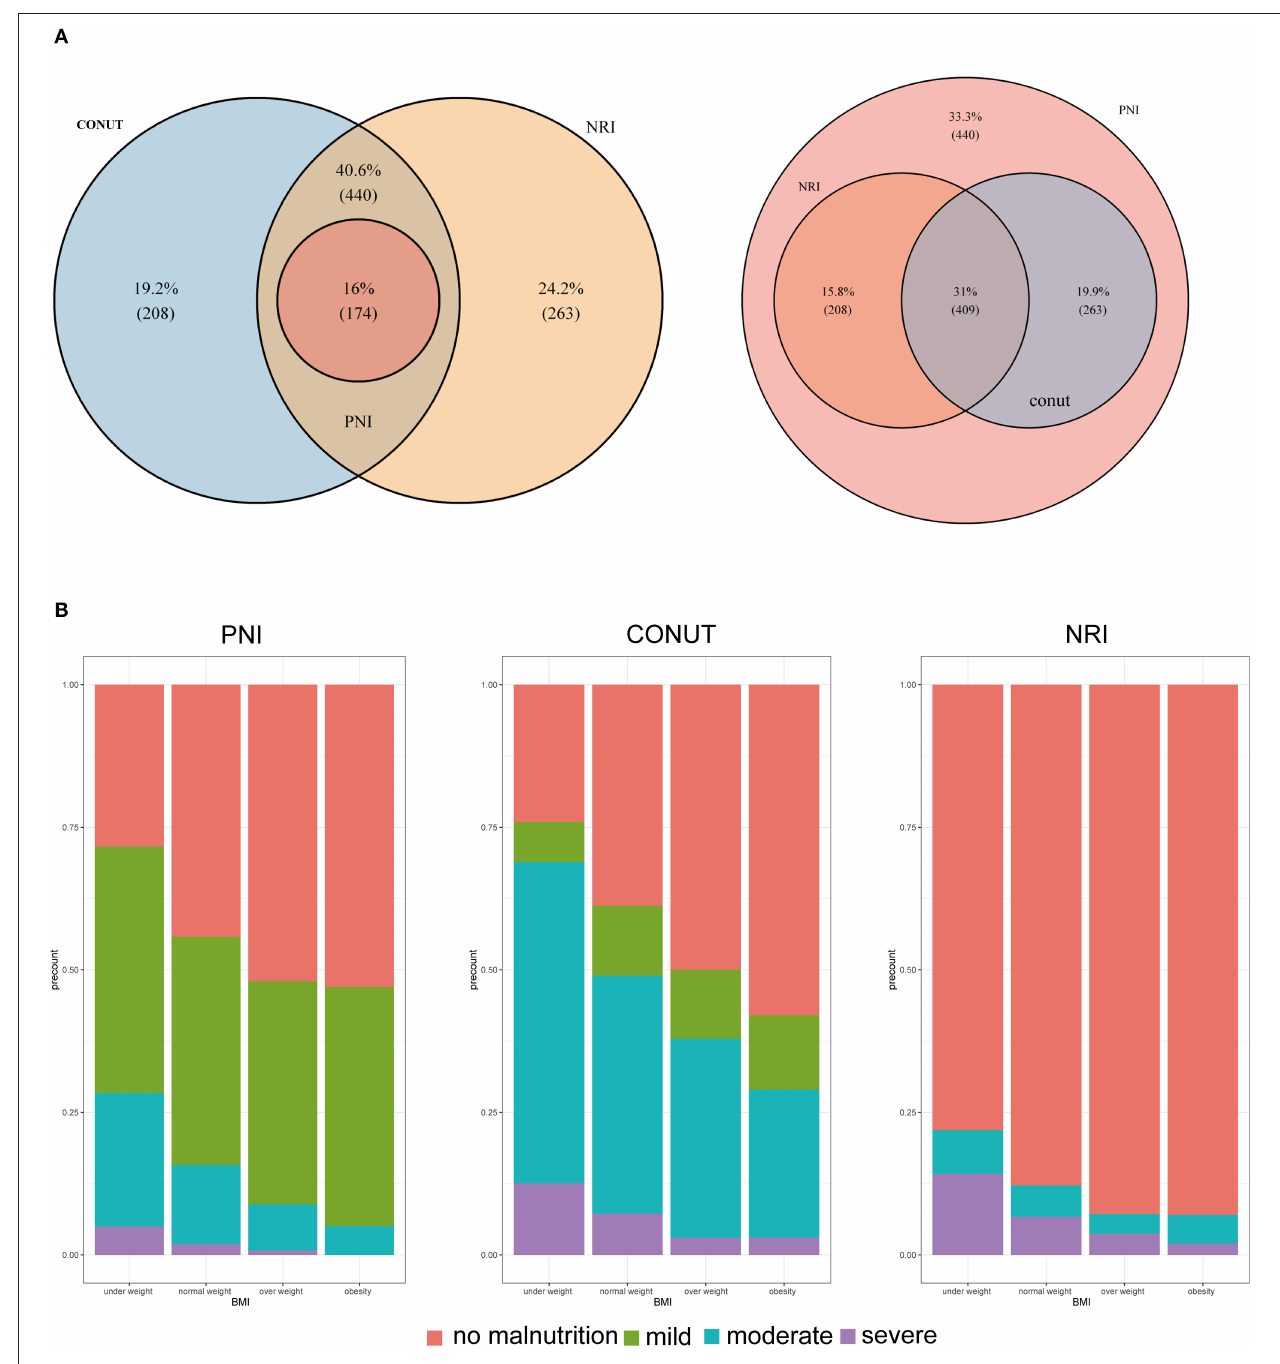
FIGURE 1 | (A) Venn diagram. The numbers reported in each circle indicate the cumulative frequency of malnutrition (any degree [left] vs. no-malnourished [right]) according to each malnutrition index. (B) Percentage of malnutrition by subgroups of patients according to body mass index. CONUT: Controlling Nutritional Status score, PNI: prognostic nutritional index, NRI: nutritional risk index.